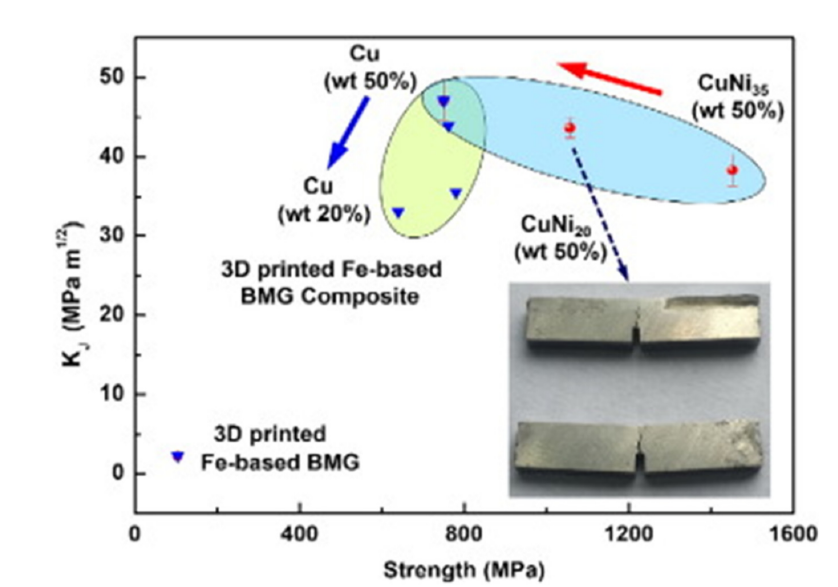
Figure 14. Fracture toughness and strength of 3D printed Fe-based bulk metallic glass composites showing effect of second phase on their properties. Reprinted with permission from ref. [392]. Copyright 2021